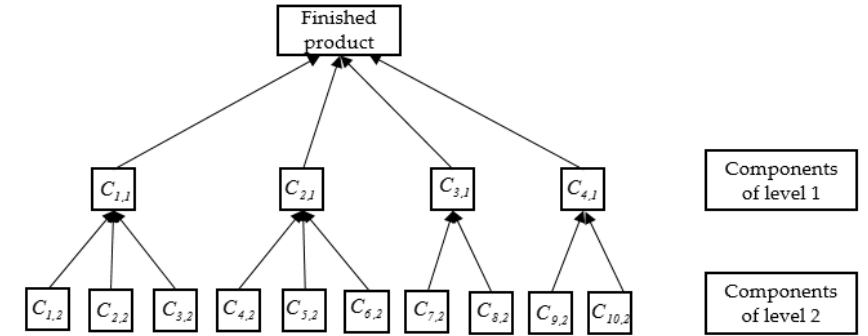
Figure 5. Nomenclature of the proposed finished product.